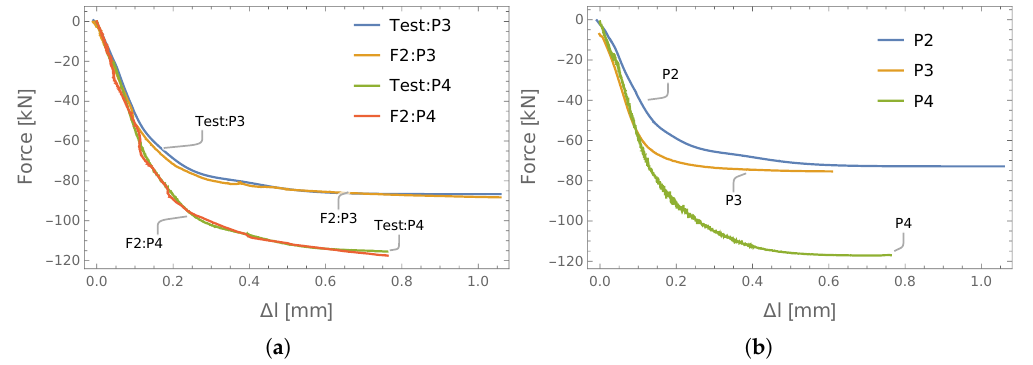
Figure 10. The results of force identification: ( a ) testing; ( b )